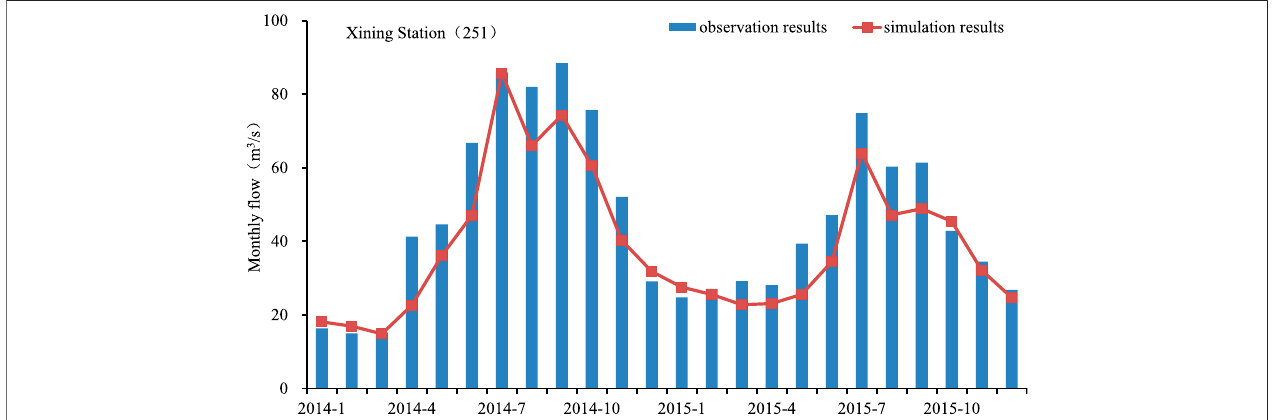
FIGURE 10 | The observed and updated simulated fl owrate results in the veri fi cation period of Xining station.